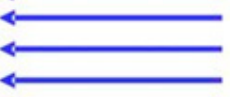
Figure 3. Polymorphic structures of chitin.